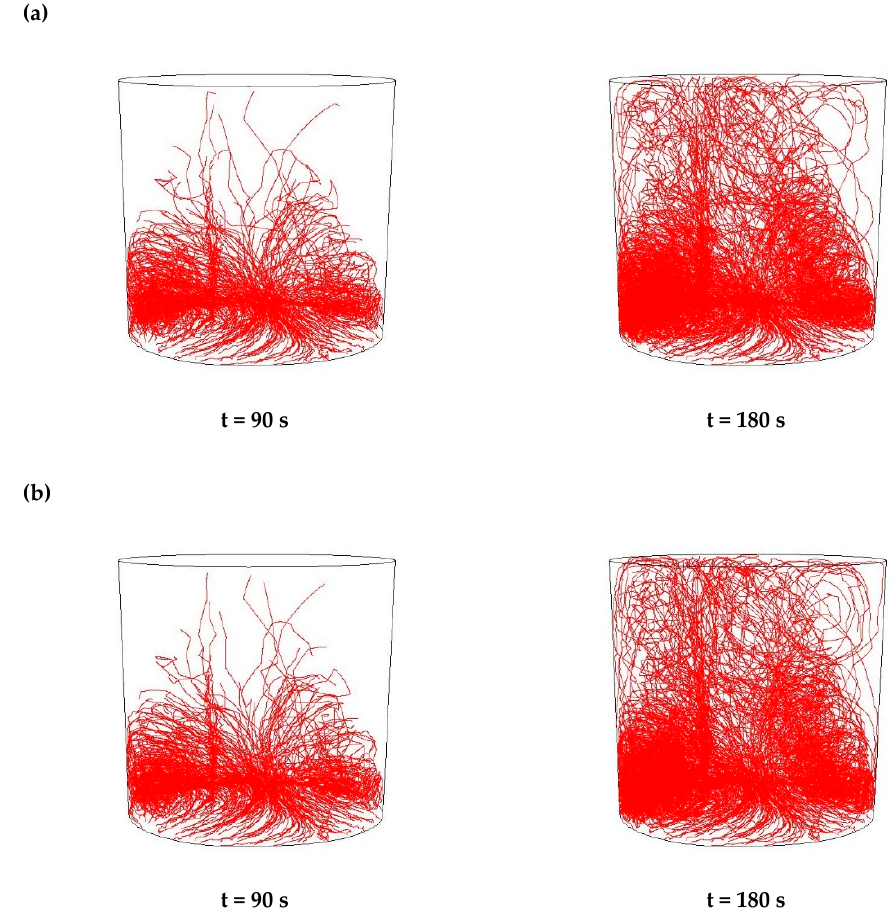
Figure 12. Trajectories of non-metallic inclusions MnS for the case of argon flow of 25 L/min for the particle diameters of ( a ) 18 µm and ( b ) 27 µm in the 42CrMo4 steel.